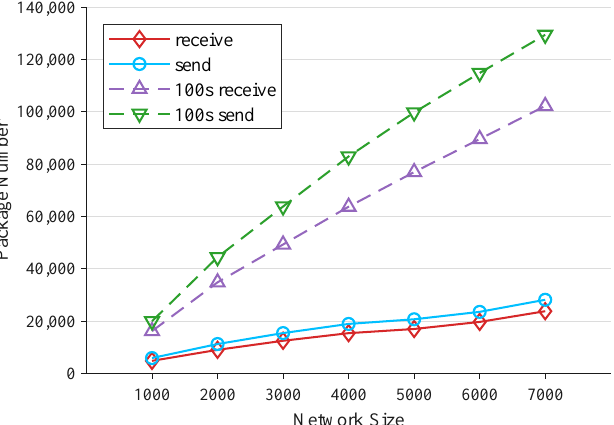
Figure 16. Average packet numbers for building overlay networks at different network size. The lower two curves show the number of packets sent and received by nodes joining without waiting time, while the upper two curves show the number of packets sent and received after 100 s of waiting time, both of which show an increasing trend. The difference between the top two curves is larger than the bottom two curves and tends to increase as the number of nodes increases, while the difference between the bottom two curves remains more or less the same. Overall, the slope of the two curves decreases slowly as the number of nodes increases and does not exceed 1 at the maximum slope, indicating that the average consumption of network resources by nodes becomes smaller as the network size increases. As the size of the network increases, the tendency to increase the average time complexity of building the network and the interactive refresh work after building decreases, which is a beneficial effect for us to build larger